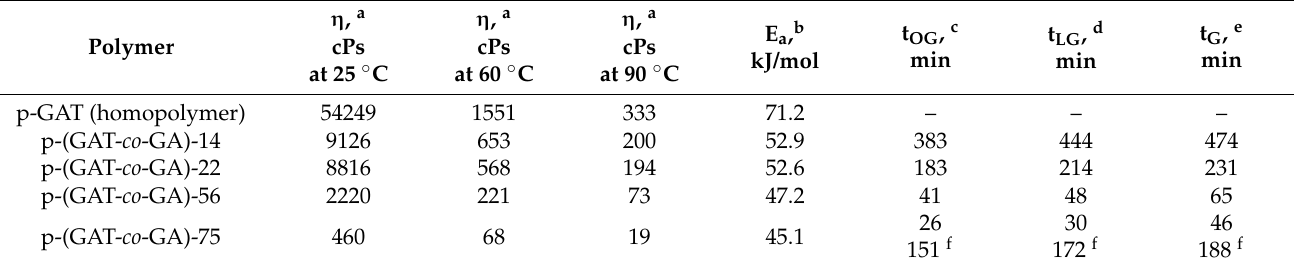
Table 3. Viscosity characteristics and rheokinetic parameters of curing (at 80 ◦ C) of the polymers plasticized with HET (in the form of 50%